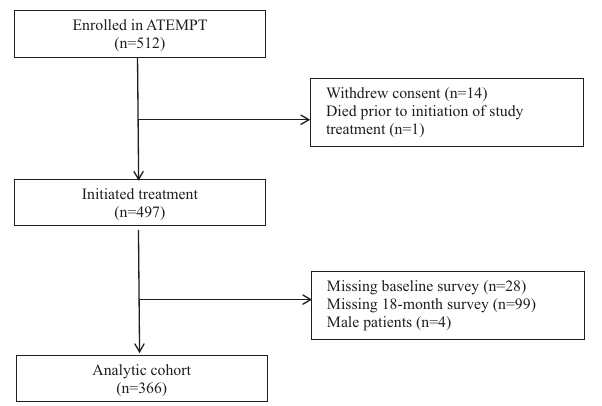
Fig. 1 Flow diagram of participants. Of 512 participants rando- mized to receive treatment with either adjuvant T-DM1 or TH, 366 were included in the current analytic cohort.